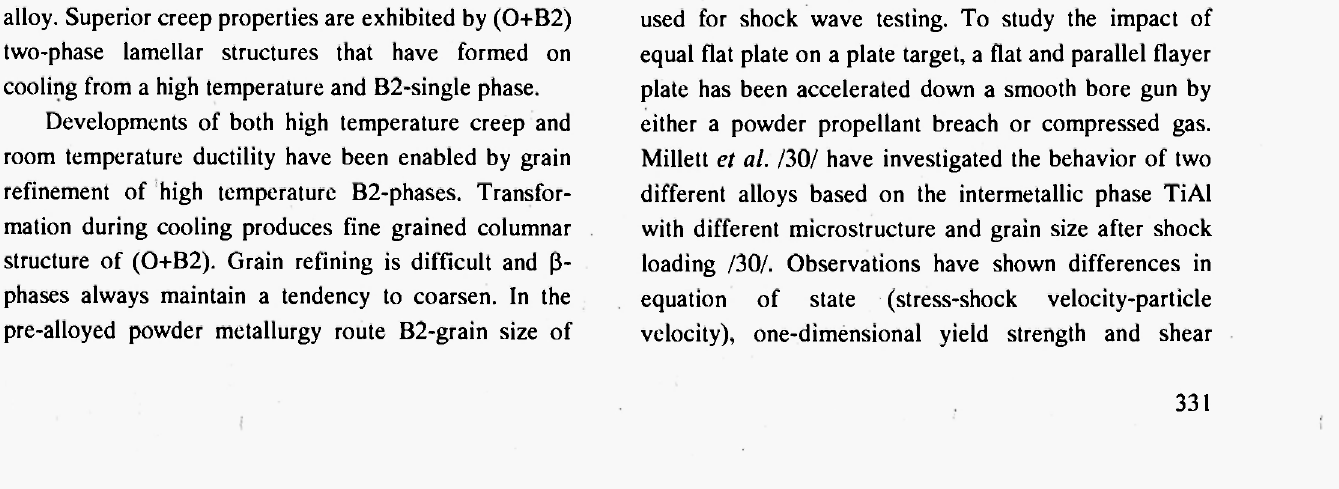
Fig. 2: Comparison of measured yield strength of the alloy (solid line) and the yield stress of the β phase estimated with the Hall-Petch equation (dotted line)